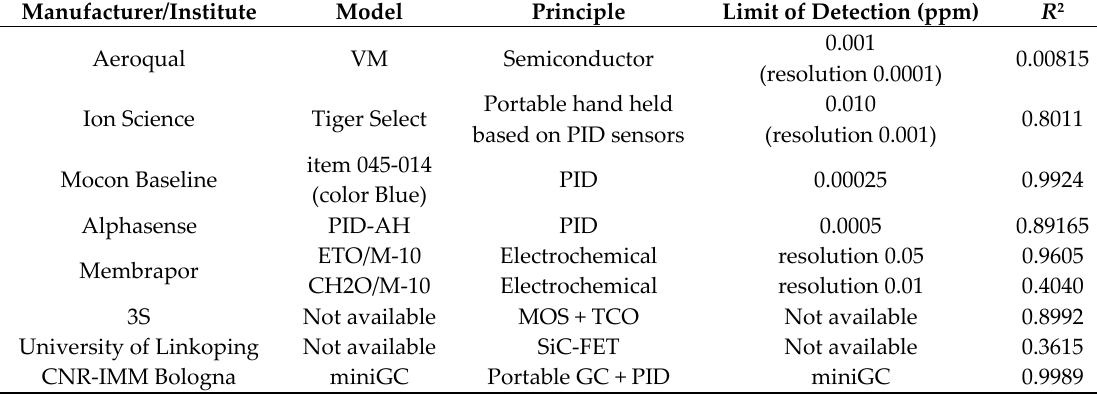
Table 1. List of commercial sensors and portable devices selected and coefficient of determination of the linear regression ( R 2